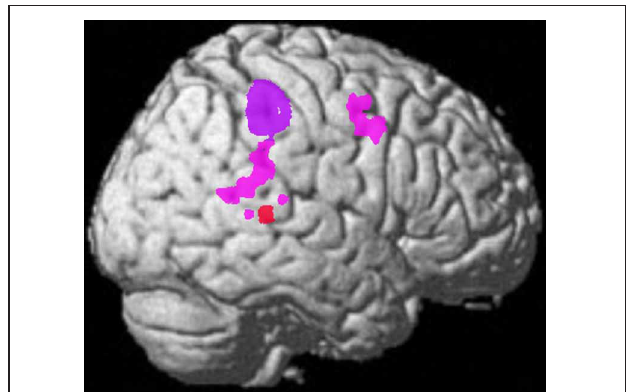
FIGURE 7 | Data from three studies of negative emotion . Red—fMRI activation in the right posterior STS was positively correlated with the perception of negative valence expressions from Lotze et al. (2006). Pink—fMRI activation of the right posterior temporal TPJ region is related to perceiving fear from body expressions re-representation from Grezes et al. (2007). Purple—core region where lesions in human subjects cause an inability to recognize negative valence expressions re-representation from Adolphs et al. (1996). Note also that activation of the right posterior STS is also related to jealousy (Rilling et al., 2004; Takahashi et al.,